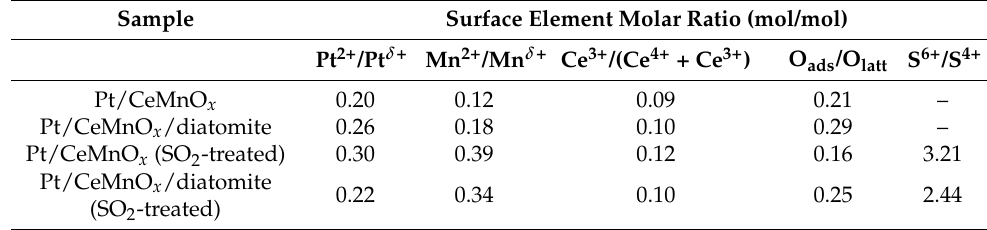
Table 4. Surface element compositions of the fresh and SO 2 -treated